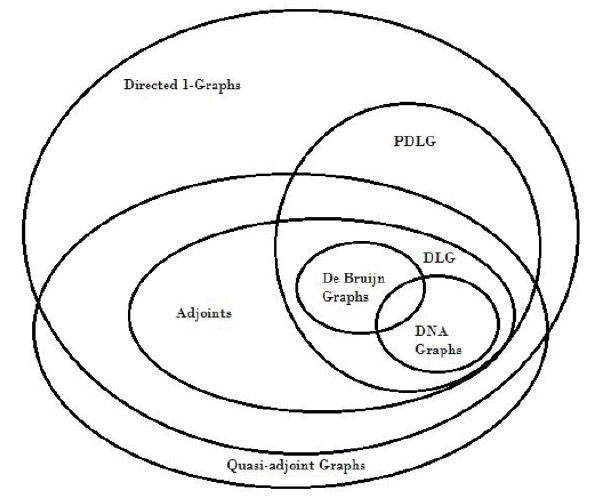
Figure 5. Belongingness of DNA graphs [16].